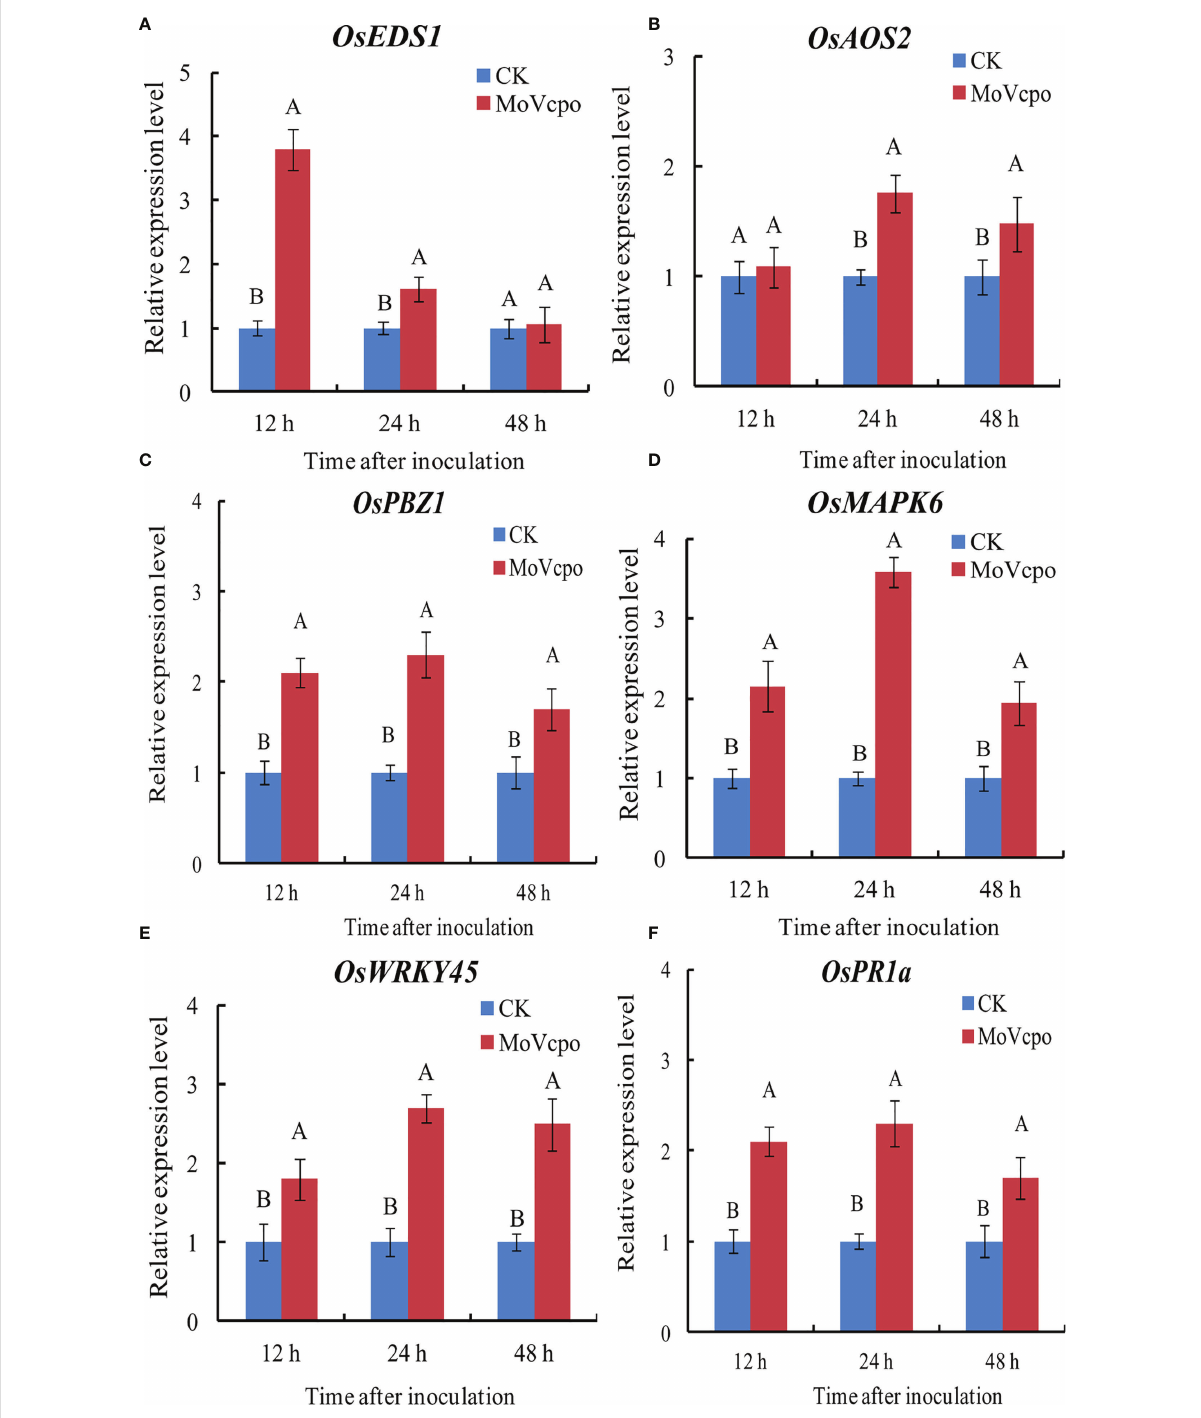
FIGURE 5 Transcription patterns of OsEDS1 (A) , OsAOS2 (B) , OsPBZ1 (C) , OsMAPK6 (D) , OsWRKY45 (E) , and OsPR1a (F) in MoVcpo-treated leaves as determined by RT-qPCR. The rice constitutive gene Osactin was used as internal reference. Values are the means ( ± SE) based on three independent experiments and bars indicate standard deviations. Different letters indicate statistical signi fi cance ( p < 0.05) using Duncan ’ s new multiple range